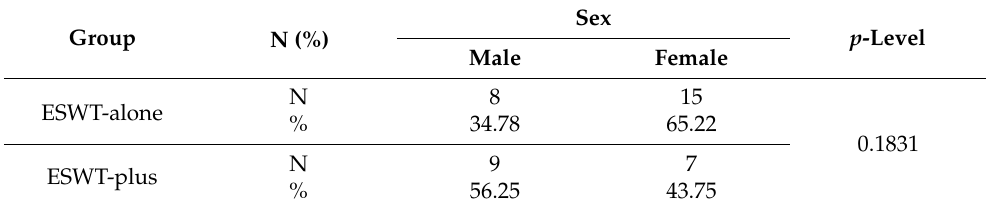
Table 1. The structure of the treatment groups according to sex.